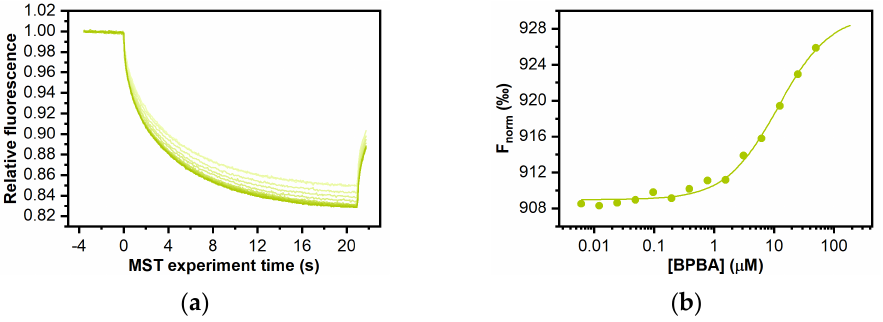
Figure 6. MST measurements on the interaction of compound BPBA with TERRA G4. ( a ) Time traces recorded by incubating increasing concentrations of BPBA with the labeled G4; ( b ) the correspond- ing binding